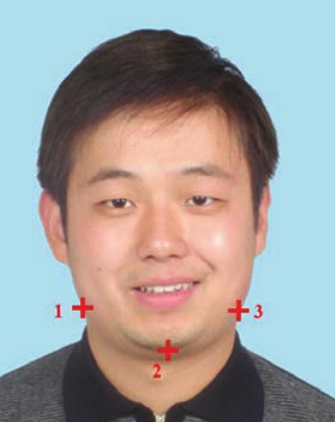
Figure 3: Three feature points detected by ASM algorithm. They are 2 intersection points between neck and face and the most bottom point of the chin is labeled by crosses with